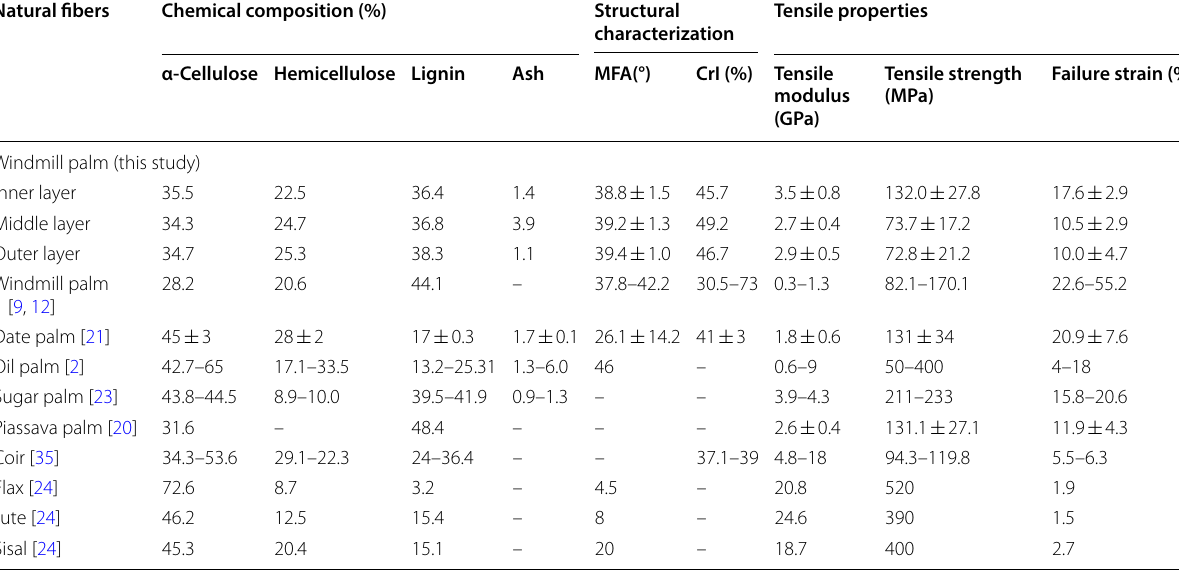
Table 2 Comparison of properties of windmill palm fibers with other natural fibers Natural fibers Chemical composition (%) Structural